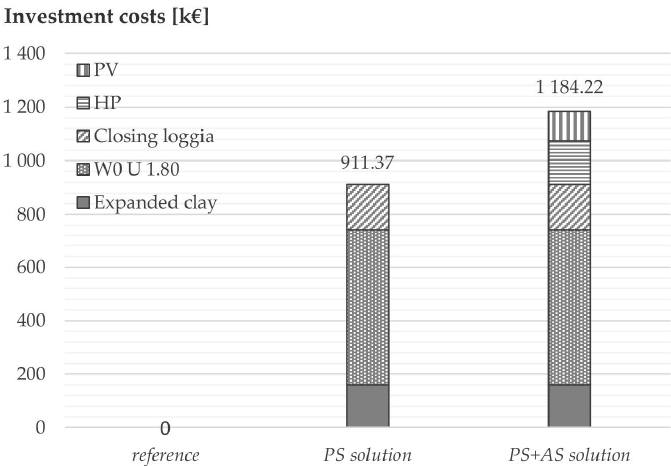
Figure 8. Comparison of the reference building, the optimal PS solution, and the PS+AS solution with respect to investment costs.